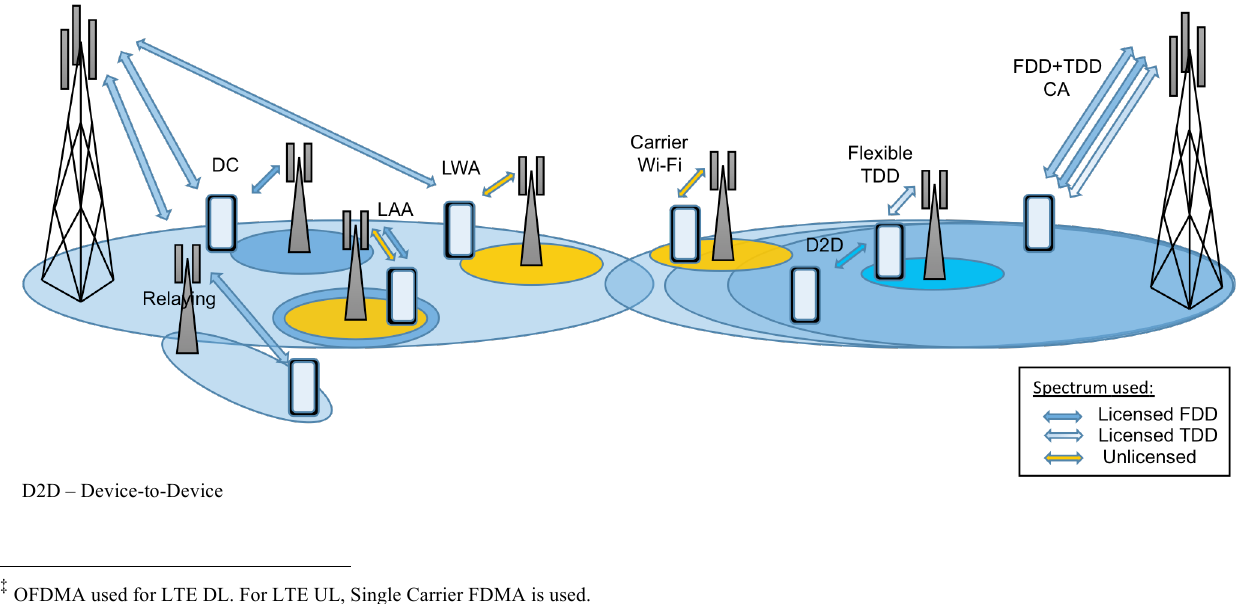
Figure 1. Spectrum toolbox landscape in